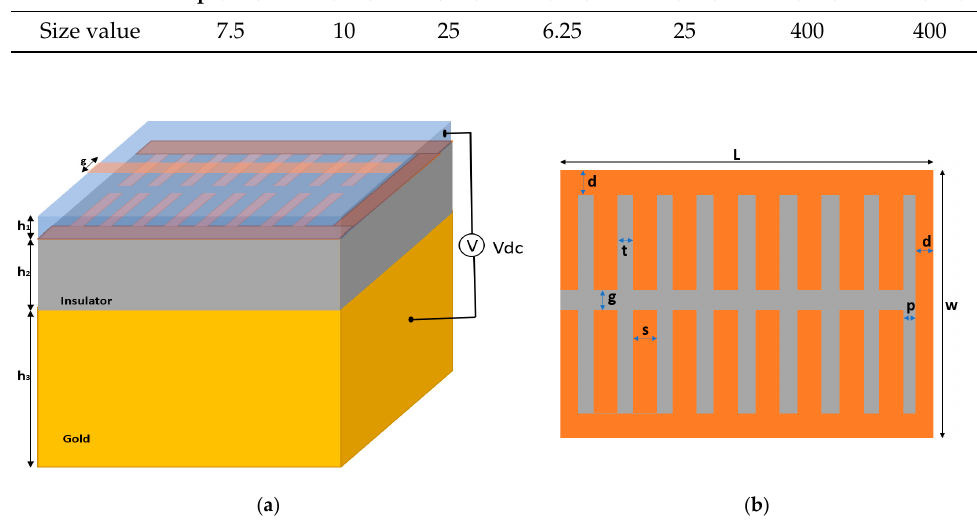
Figure 1. Schematic diagram of terahertz graphene absorber. ( a ) 3D structure. ( b ) From the top view. In the case of the graphene layer, the conductive surface has opted for analysis of construction, and the graphene layer’s thickness is 1nm in the model [38,39]. For extrac- tion of the desired conductivity concerning graphene by Equation (2), we consider the temperature and relaxation time as 300 K and 1 ps, respectively [28,40]. Considering the appropriate data related to temperature and relaxation time is essential for the structure design because these parameters can change the conductivity and optical properties of the graphene sheet. As mentioned earlier, the initial geometric values of the combline gra- phene layer are demonstrated in Table 1. Accordingly, the number of ribbons of the gra- phene layer in the initial design is 23 on each side. Table 1. Initial geometries of the combline graphene layer embedded for perfect absorber. Parameter